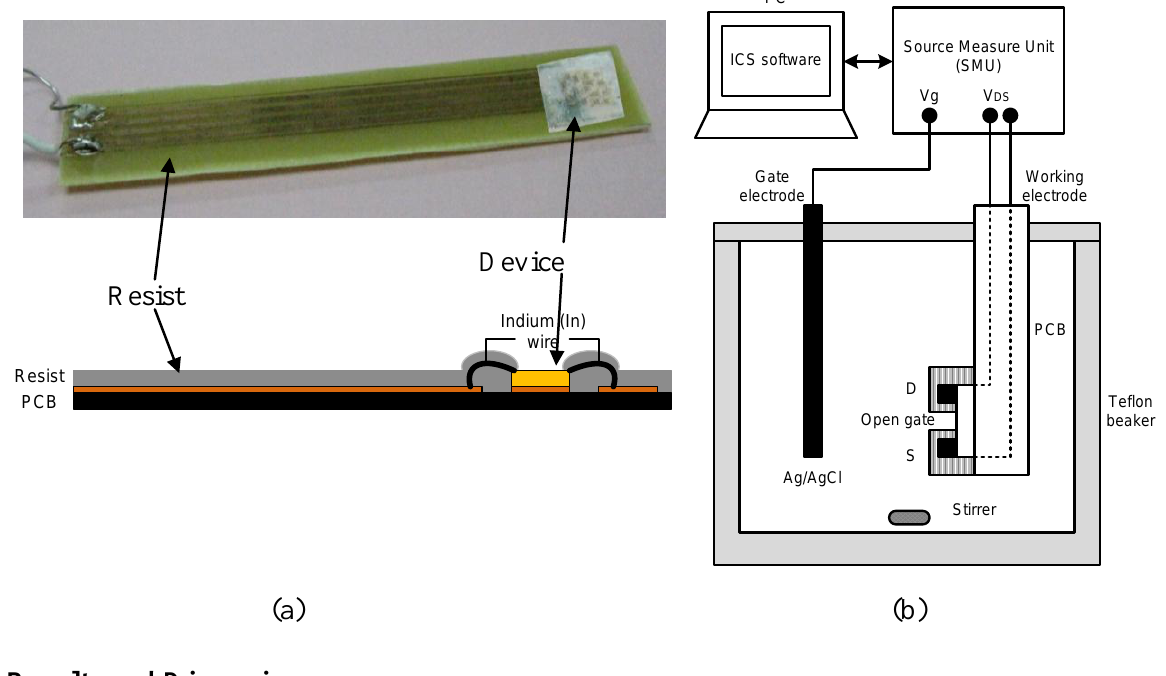
Figure 3. (a) Photo and schematic of sample holder and (b) schematic of the electrochemical system and measurement circuit.